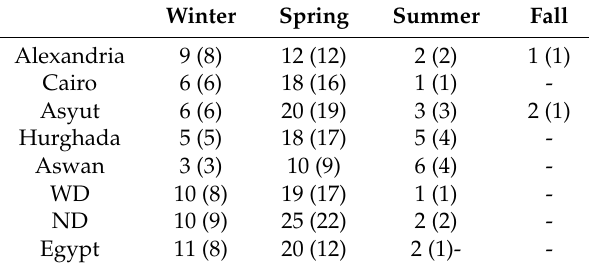
Table 6. Number of days of SAPEs within each city, the two regions, and the entire country. The number of events is shown between brackets. Data are averaged over the 50-km domain and accumulated over the 12-year study period.